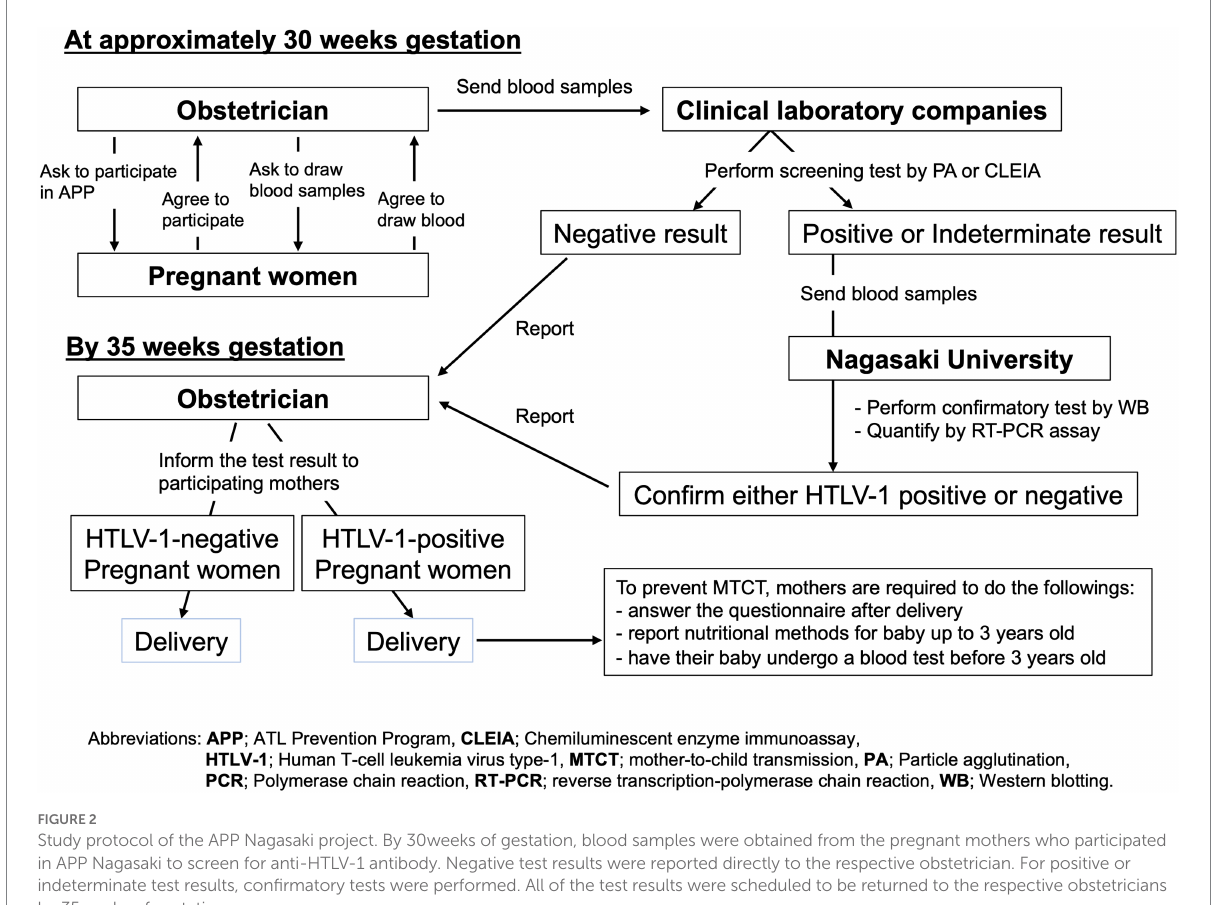
FIGURE 2 Study protocol of the APP Nagasaki project. By 30 weeks of gestation, blood samples were obtained from the pregnant mothers who participated in APP Nagasaki to screen for anti-HTLV-1 antibody. Negative test results were reported directly to the respective obstetrician. For positive or indeterminate test results, confirmatory tests were performed. All of the test results were scheduled to be returned to the respective obstetricians by 35 weeks of